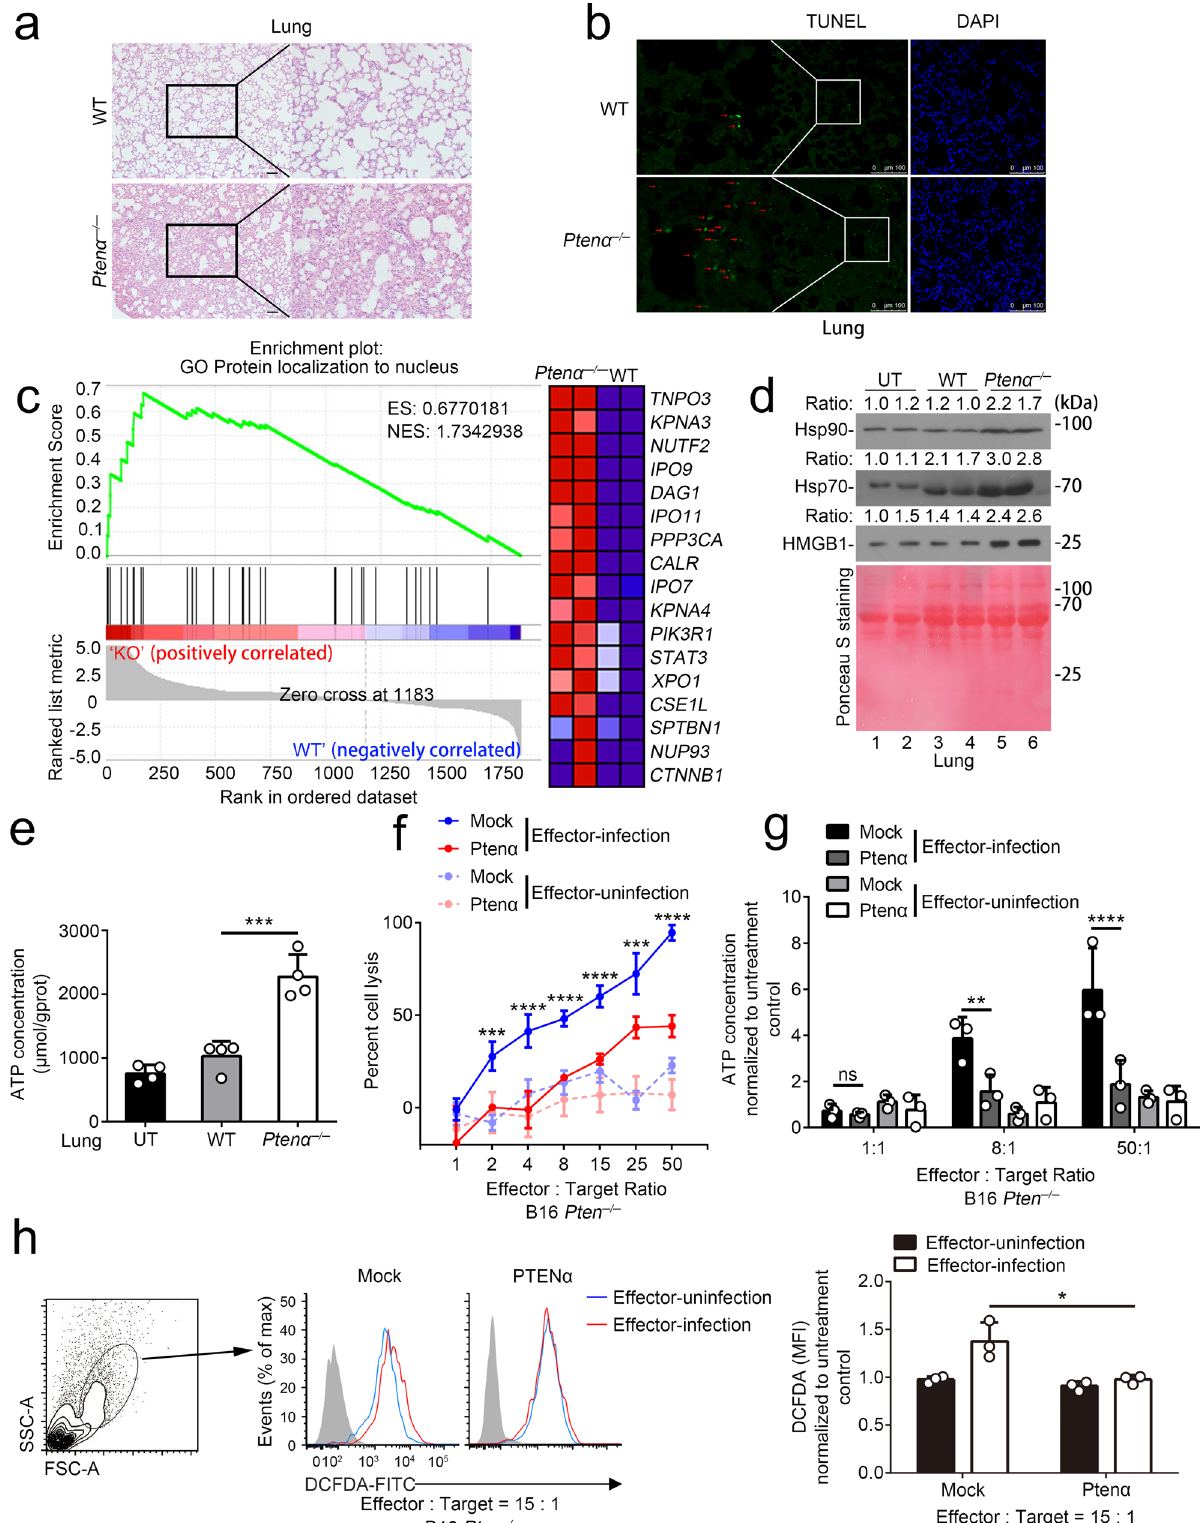
the effectiveness of tumor vaccination (Fig. 7i). Our data thus demonstrate that Gpx4 largely contributes to the stimulatory role of PTEN α in cancer immune escape.